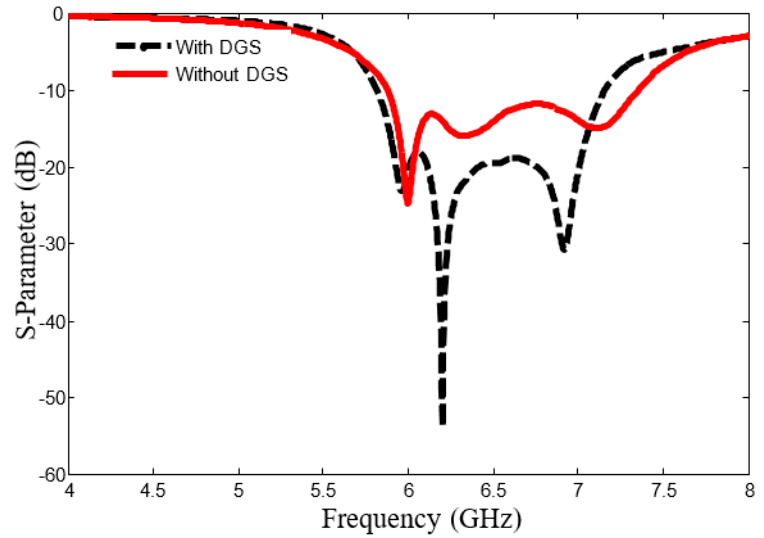
Figure 4. S11 ‐ parameter of the proposed filtering antenna with and without defected ground structure (DGS).